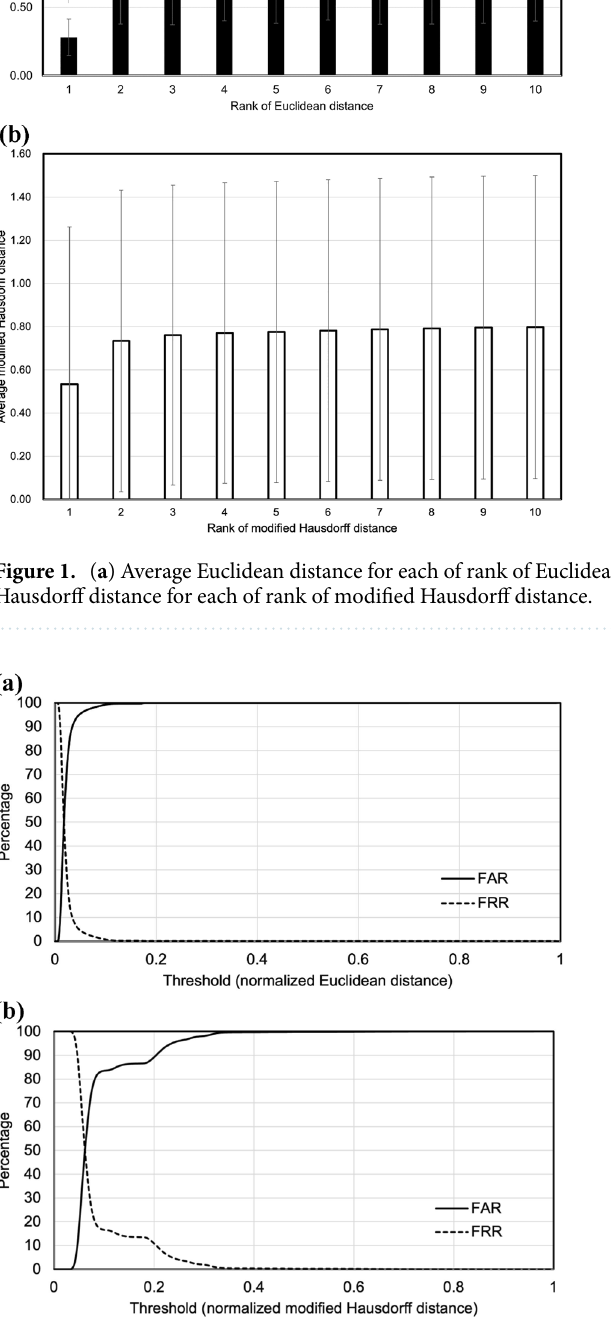
Figure 2. ( a ) FAR and FRR for normalized Euclidean distance. ( b ) FAR and FRR for normalized modified Hausdorff